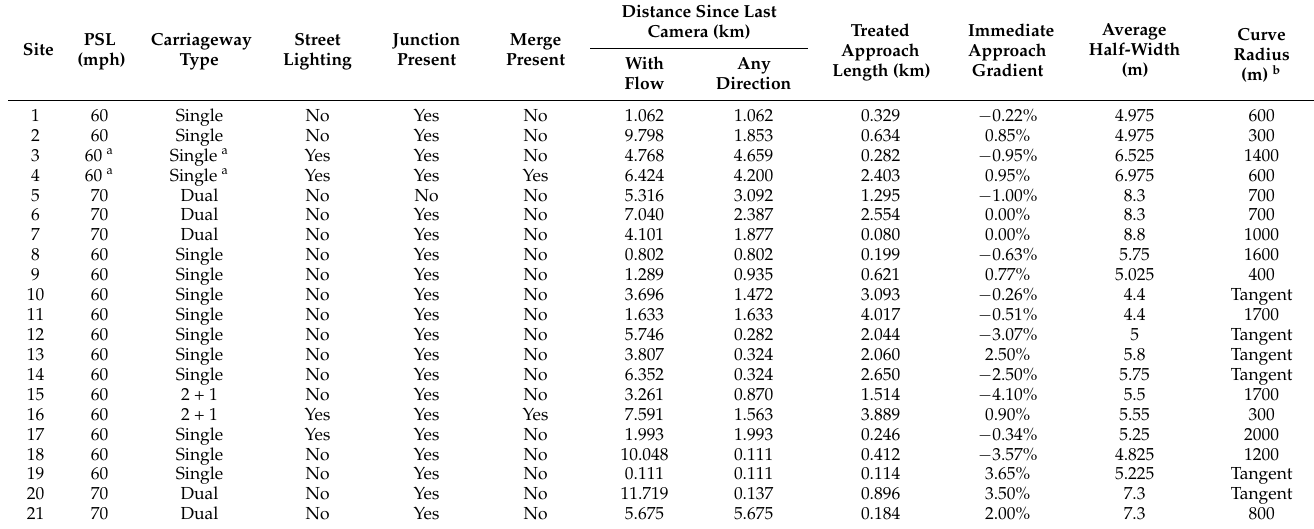
Table 5. Speed survey site characteristics.